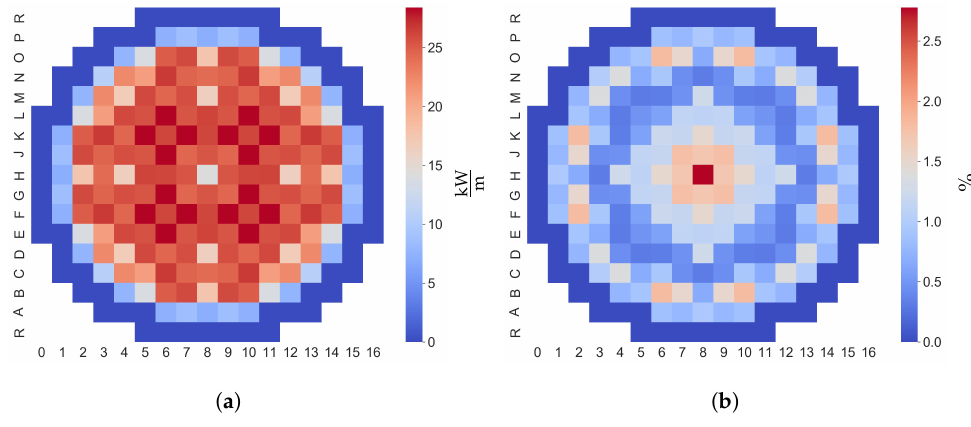
Figure 19. Radial profile of P ave